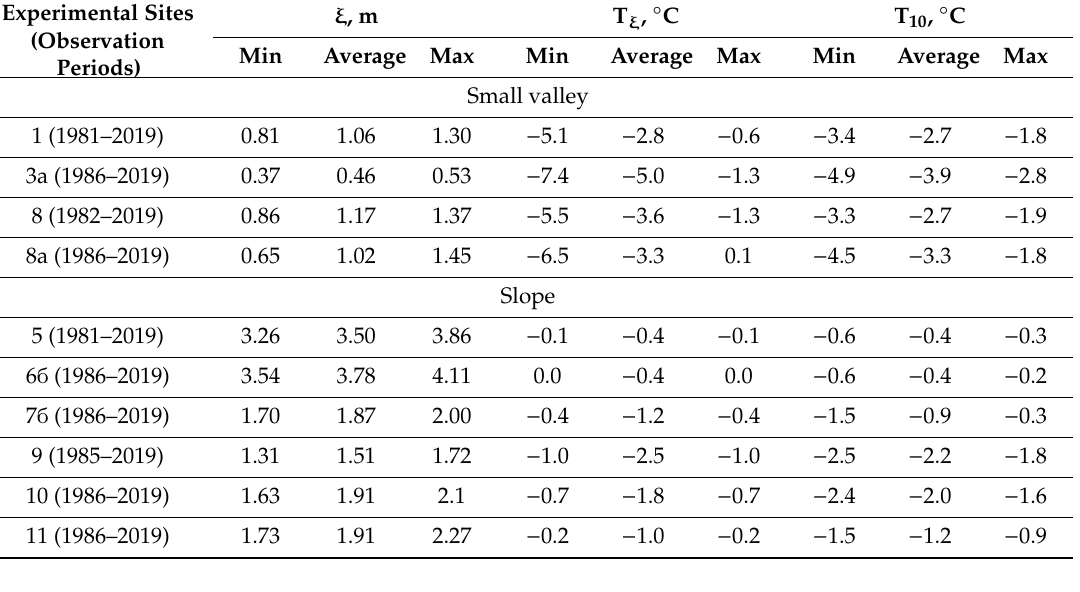
Table 4. Long-term average and extremes of the main ground thermal parameters within the layer of annual temperature